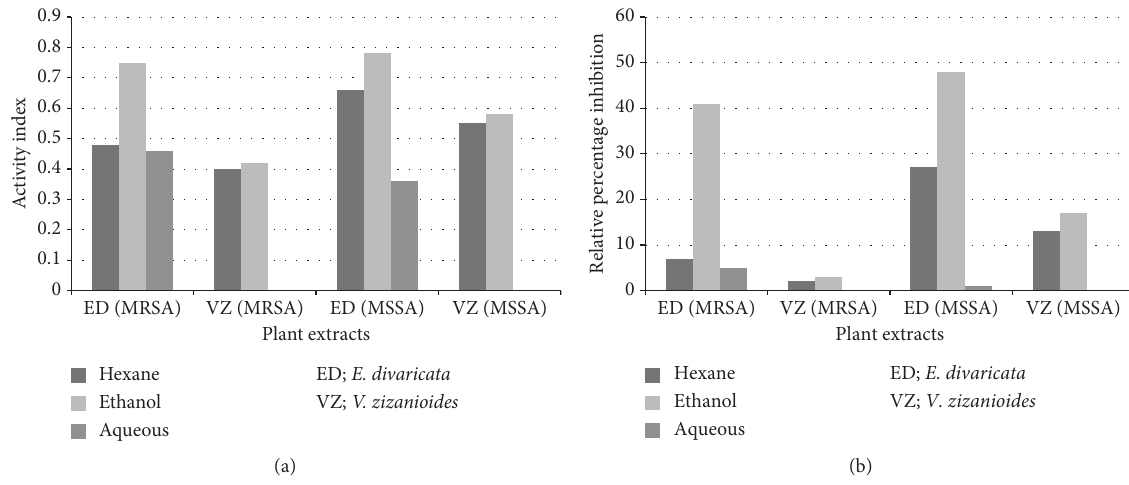
Figure 4: Activity index (a) and relative percentage inhibition (b) of crude extracts of E. divaricata and V. zizanioides for MRSA and MSSA. Table 2: MIC values of E. divaricata and V. zizanioides against MRSA